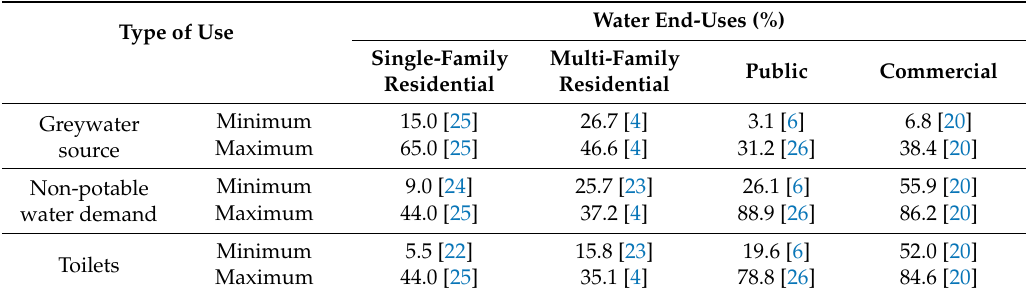
Table 1. Minimum and maximum water end-uses of greywater sources, non-potable water demand and toilets used for determining the water end-uses